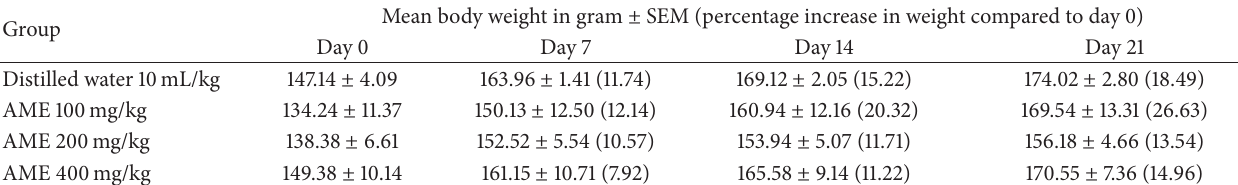
Table 1: The effects of AME on the body weight of the treated rats.